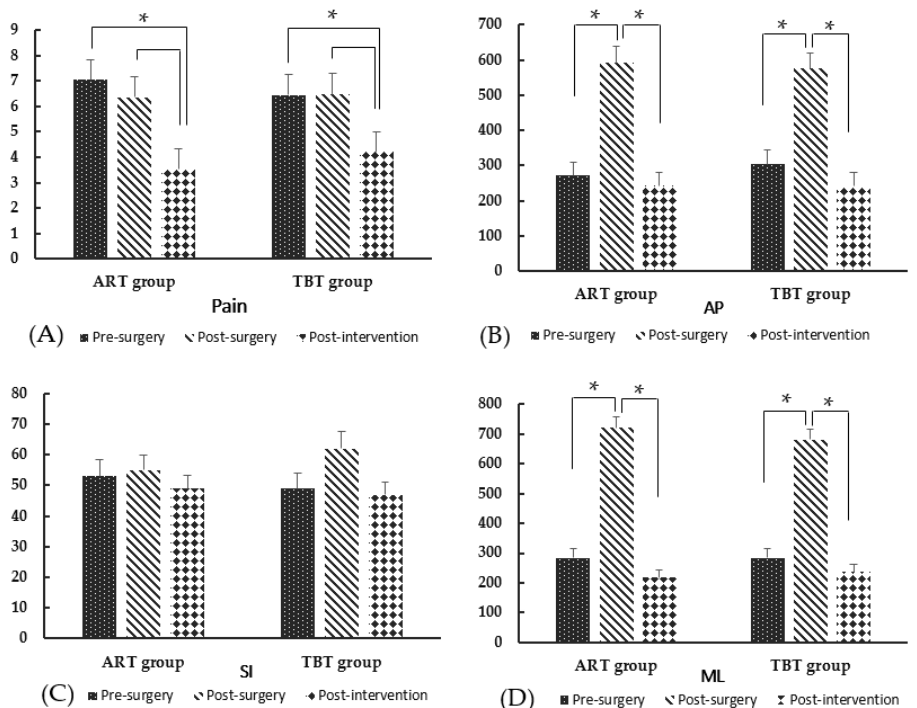
Figure 5. Comparison of pain and balance within groups. ( A ) Pain, ( B ) balance (anterior–posterior),